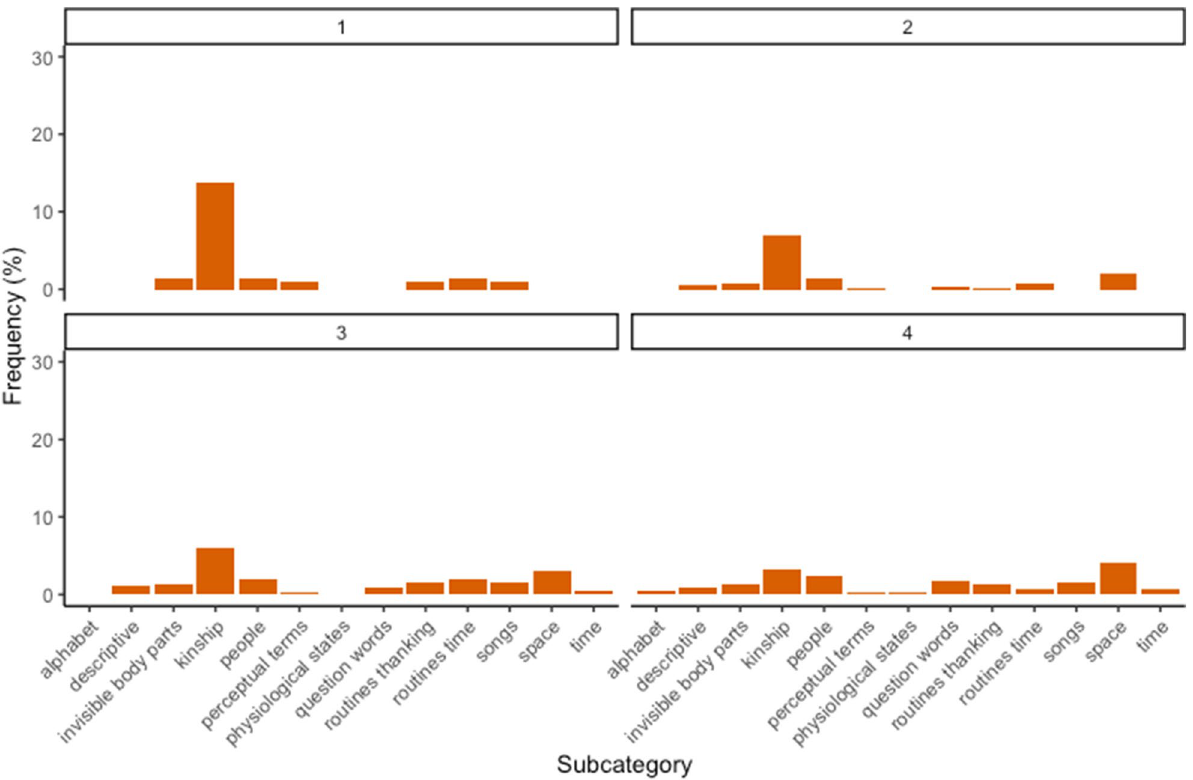
Figure 3. Percentage of words produced by children of age group 1 (12–15 months), age group 2 (16– 18 months), age group 3 (19–21 months) and age group 4 (22–24 months) for subcategories with medium level of